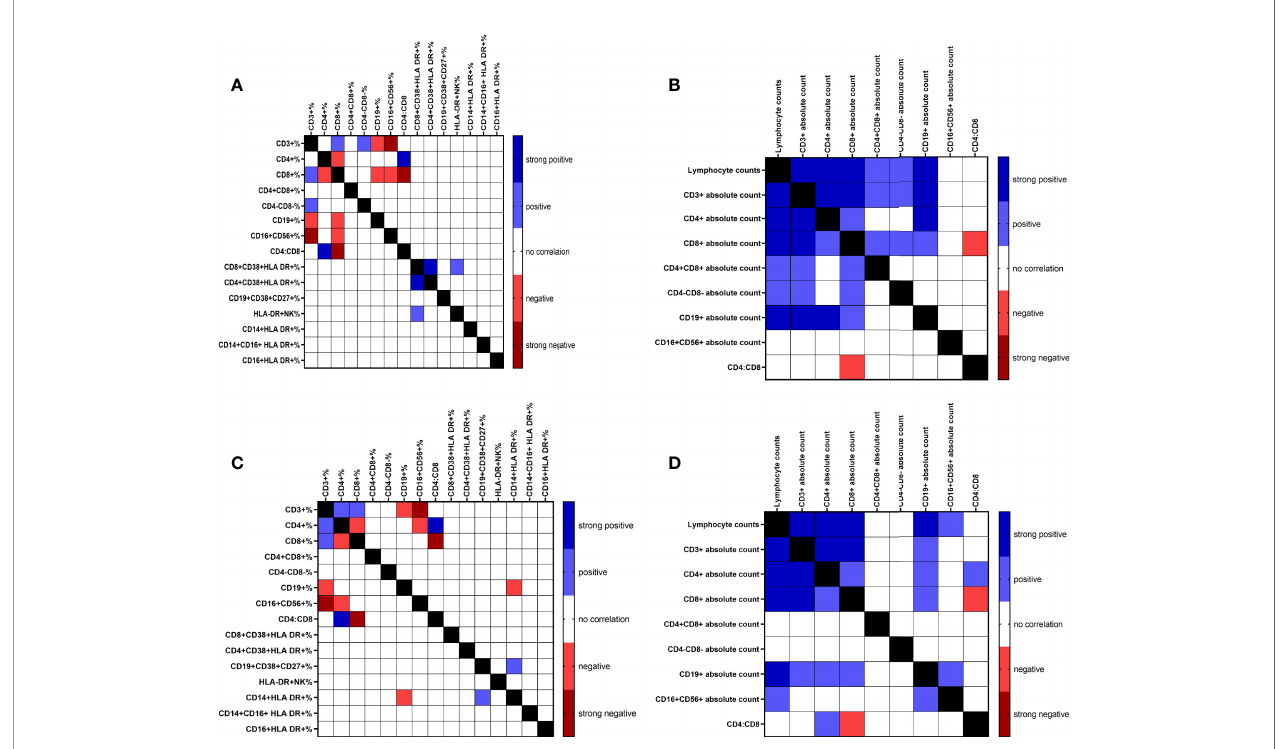
FIGURE 4 | Correlation heat map of all measured immune cell populations percentage and absolute counts of COVID-19 infected patients ( A & B , respectively) and percentage and absolute counts of vaccinated subjects ( C & D ,